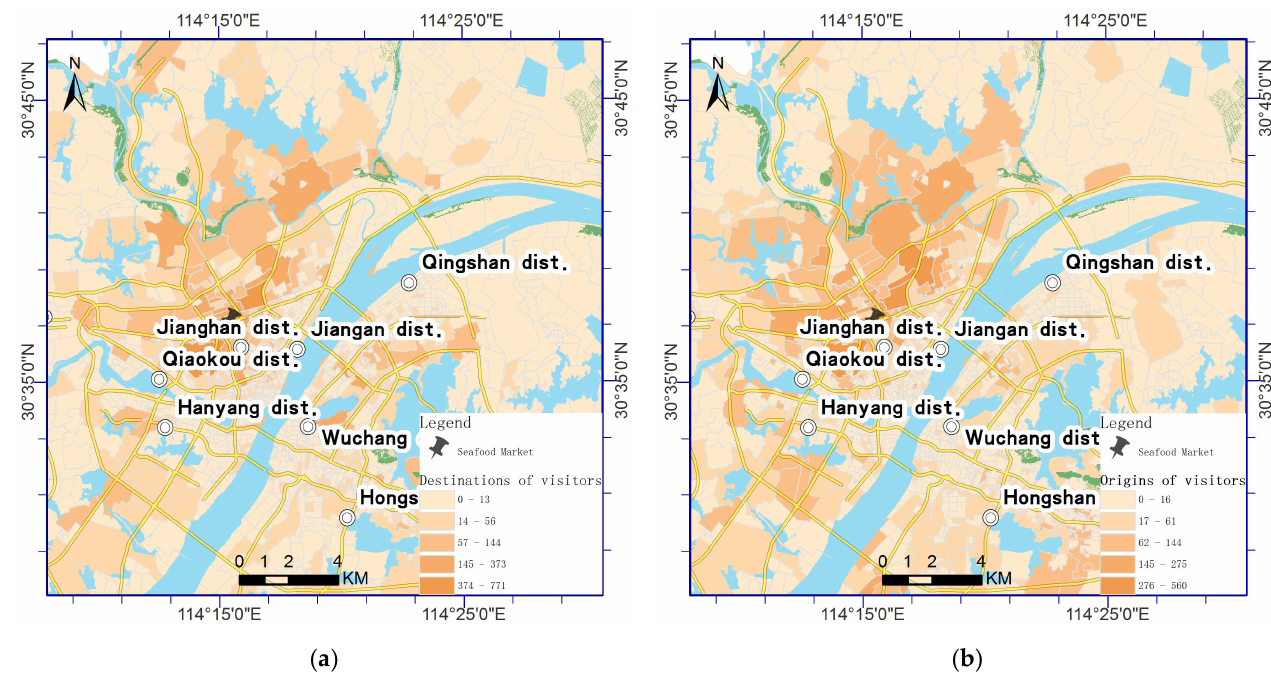
Figure 7. The distribution of the market’s visitors (( a ) The destinations of people who traveled from the market (T1); ( b ) The origins of people who traveled to the market (T2)).